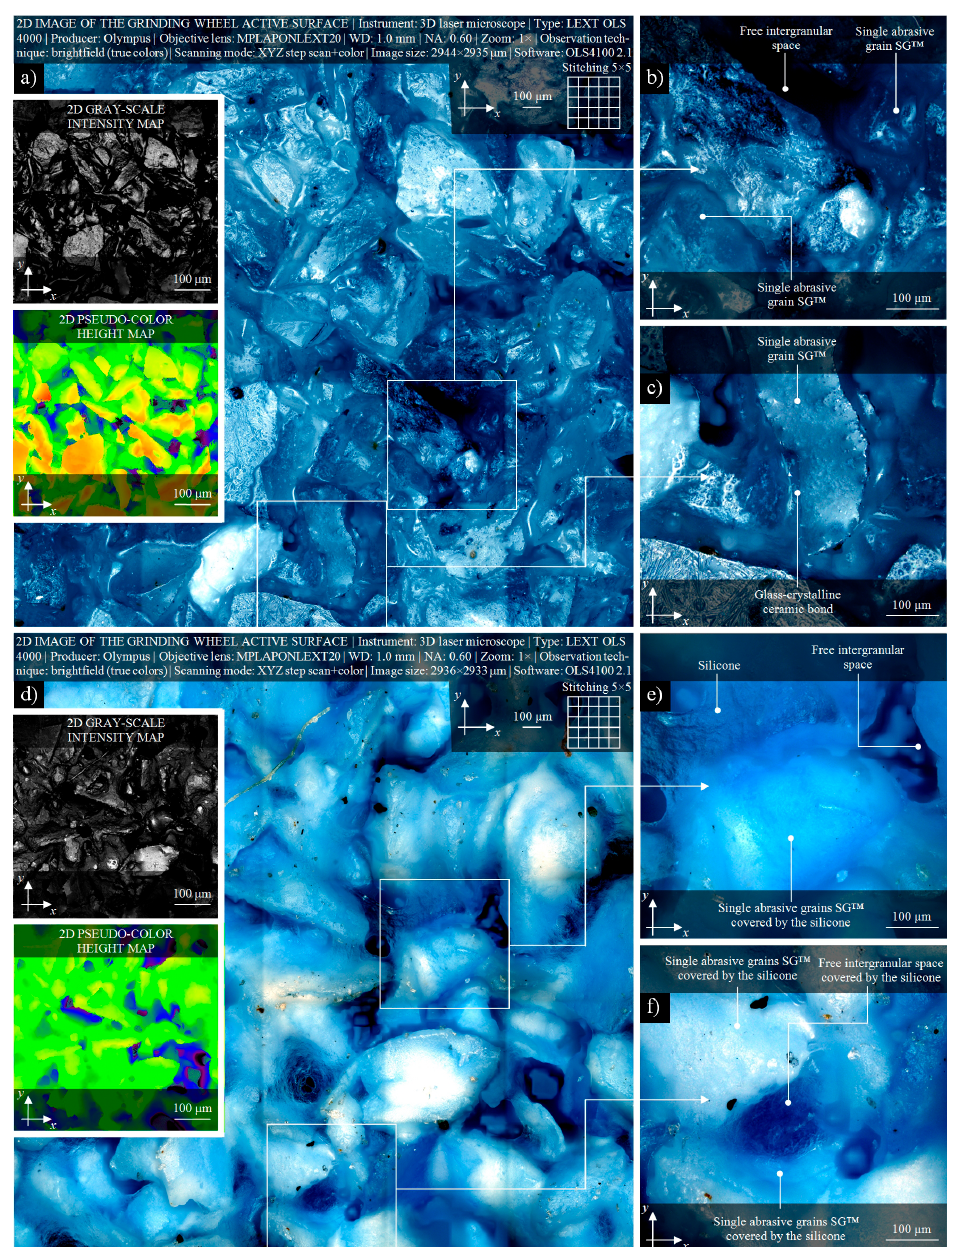
Figure 3. ( a ) Observation and visual analysis of correctness of introduction of the synthetic organosilicon polymer-based impregnate (silicone) into the active surface of small-size grinding wheel 1-35×10×10 SG/F46G10VTO carried out by the use of 3D laser microscope Olympus LEXT OLS4000: active surface of non-treated RGW-1 (size: 2944 × 2935 μ m) with 2D gray-scale intensity map and 2D pseudo-color height map (miniatures, left side top); ( b , c ) detailed views of active surface of non-treated RGW-1, each extracted AOIs (size: 0.58 × 0.58 μ m); ( d ) active surface of STGW-3 after the impregnation process (size: 2936 × 2933 μ m) with 2D gray-scale intensity map and 2D pseudo-color height map (miniatures, left side bottom); ( e , f ) detailed views of active surface of STGW-3 after the impregnation process, each extracted AOIs (size: 0.58 × 0.58 μ m).